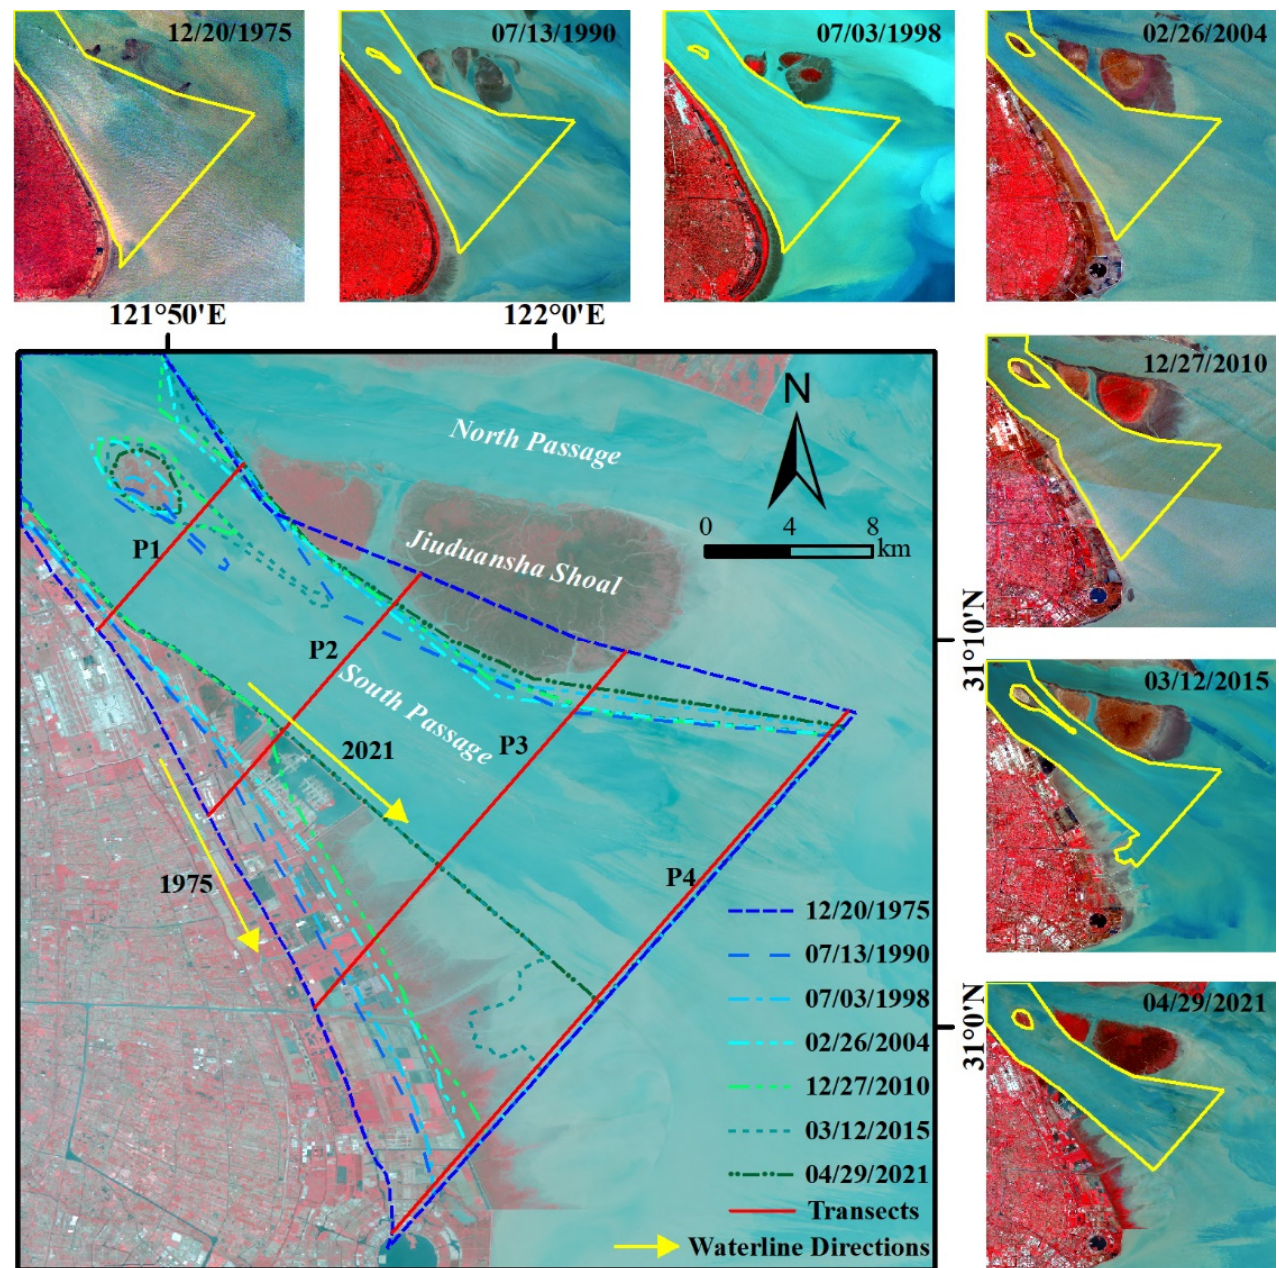
Figure 10. Evolution of the South Passage Trumpet-shape during 1975–2021.